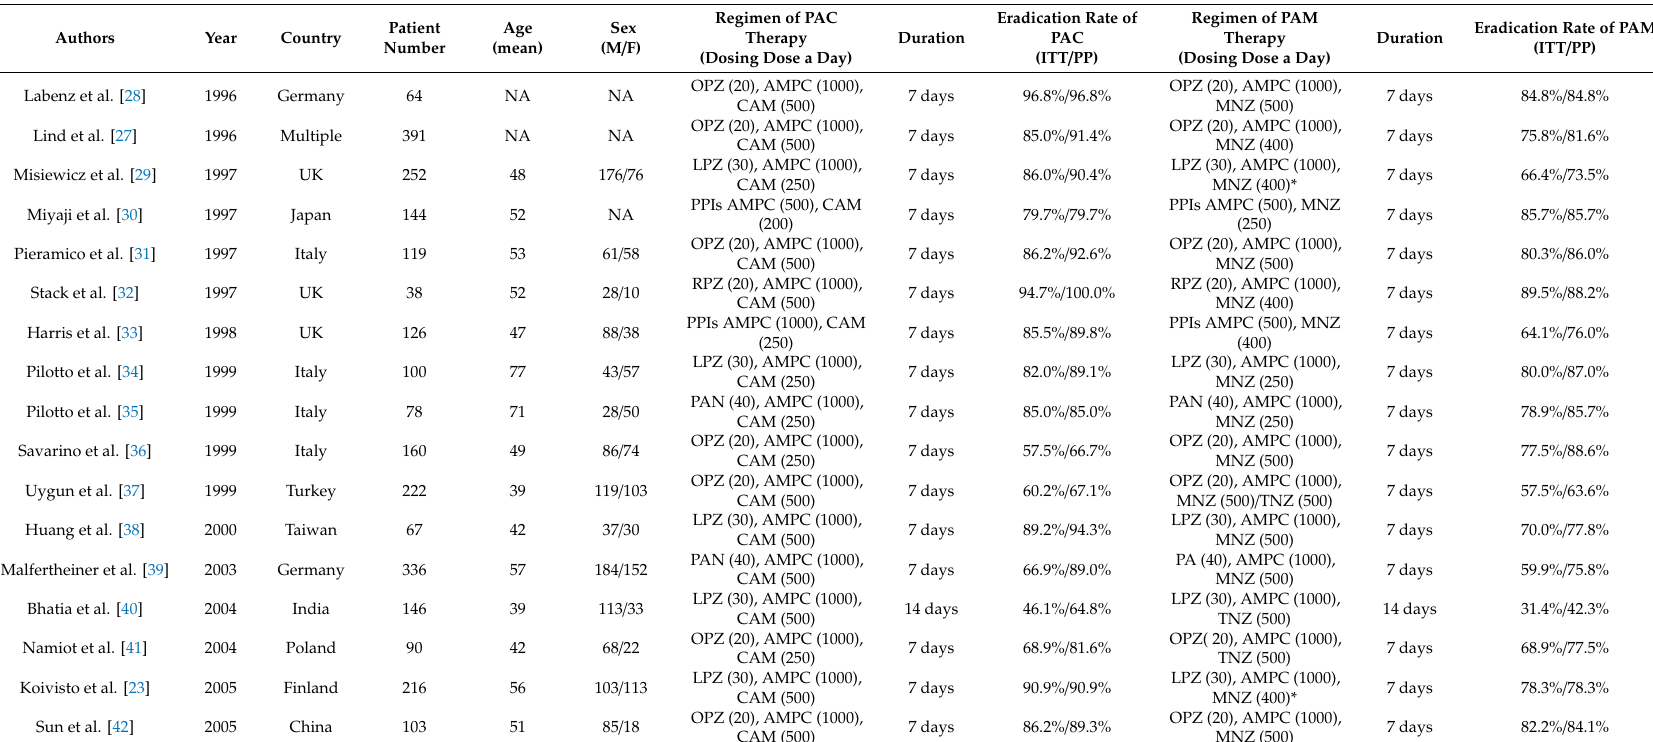
Table 1. Characteristics of the studies comparing e ffi cacy of PAC vs. PAM